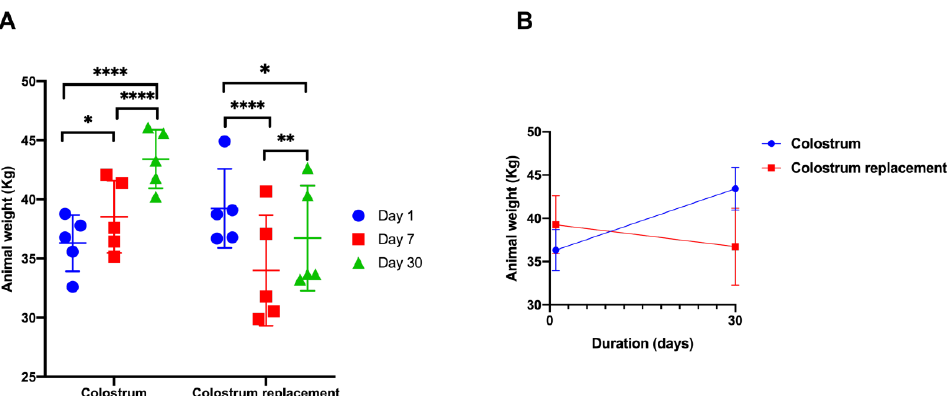
Figure 1. The effects of timely administration of colostrum result in increased body weight in the calves. The experimental animals received colostrum ( n = 5) or artificial colostrum replacement ( n = 5) for the first 6 h after birth. Panel ( A ) demonstrates the changes in body mass during on day 1, 7 and 30. Panel ( B ) demonstrates the body mass changes from day 1 to day 30. The changes in body weight were recorded at days 1, 7 and 30. The results are shown as mean ± SEM from five experimental animals. * , ** , ****—denotes significance between time points of the same group.